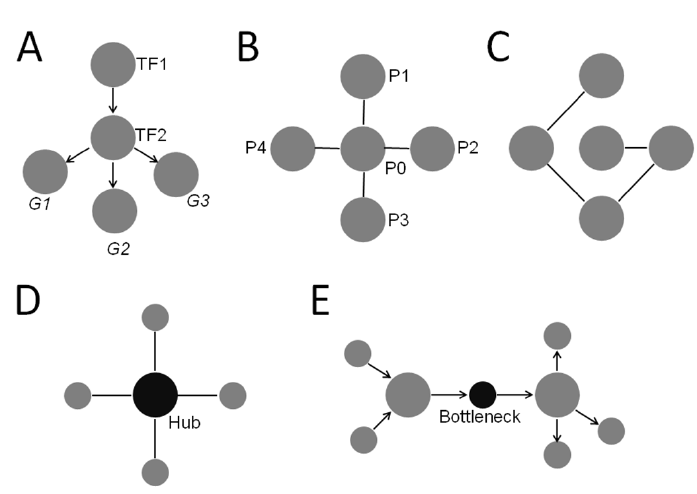
Figure 1. Representative networks and network metrics. ( A ) A hypothetical gene regulatory network showing nodes connected by directed edges. TF1 and TF2: Transcription factors 1 and 2. G1, G2, and G3: Genes 1, 2, and 3. ( B ) A hypothetical protein and protein interaction network showing nodes connected by undirected edges. P0, P1, P2, P3, and P4: Proteins 0, 1, 2, 3, and 4. ( C ) An example of a random network. ( D ) A network with the node of high degree centrality, referred as a “hub”, shown in black. ( E ) A network with the node of high betweenness centrality, referred as a “bottleneck”, shown in